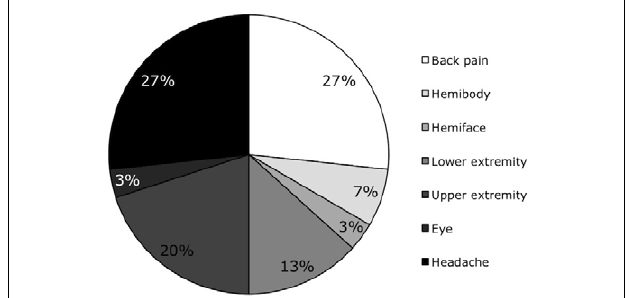
FIGURE 1 | Pain localization. Data obtained from the short version of the Brief Pain Inventory.